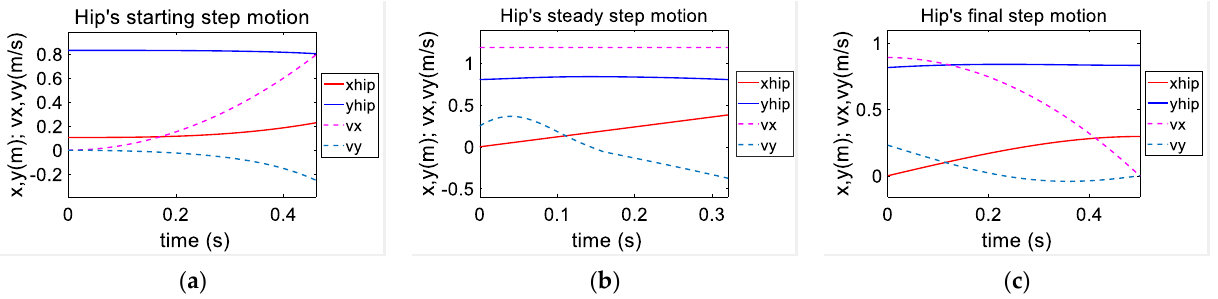
Figure 5. The motion of the hip joint in the starting ( a ), steady ( b ), and final ( c ) steps.